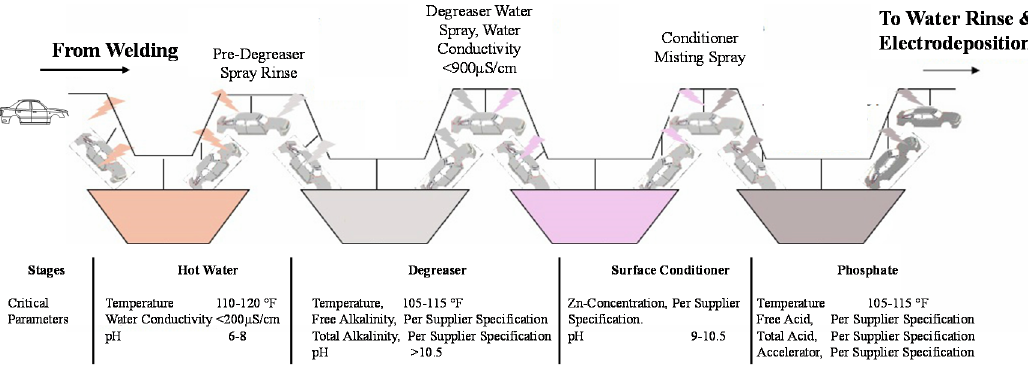
Figure 3. Pretreatment sequences for the body ‐ in ‐ white.